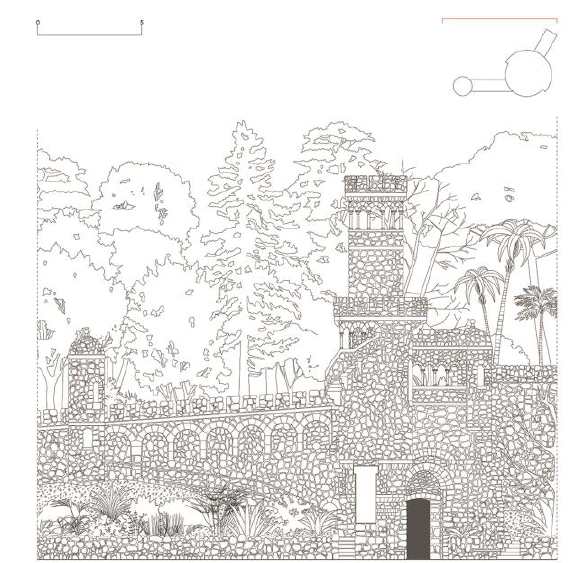
Figure 1 . The Quinta da Regaleira in Sintra, the Torre da Regaleira and the Gruta da Leda , main prospect.